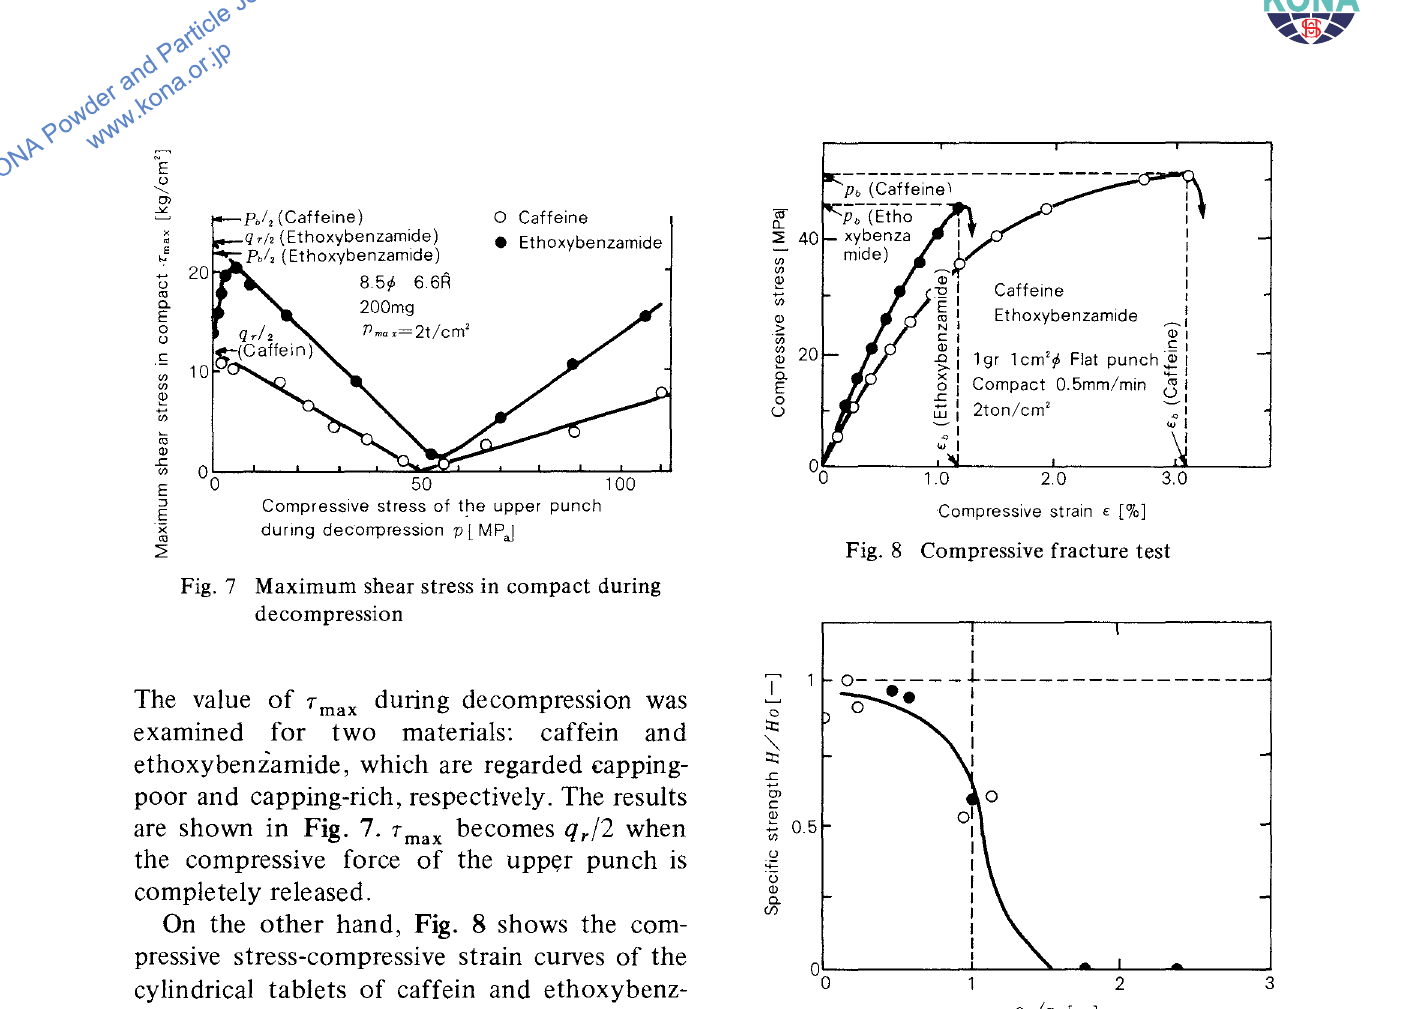
Fig. 9 qrfPb and